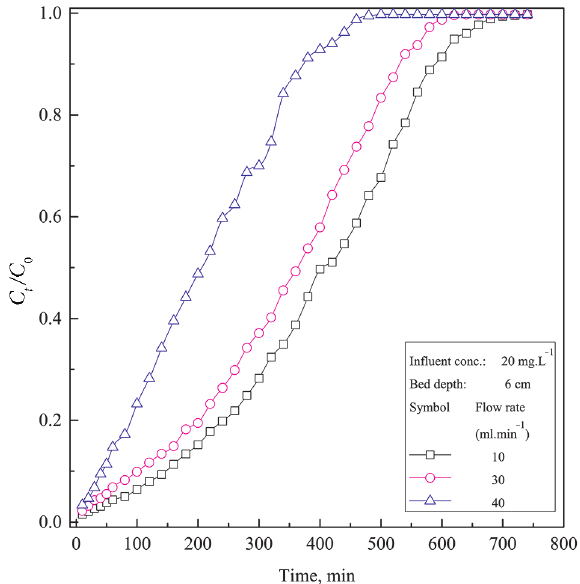
Figure 5. The effect of the flow